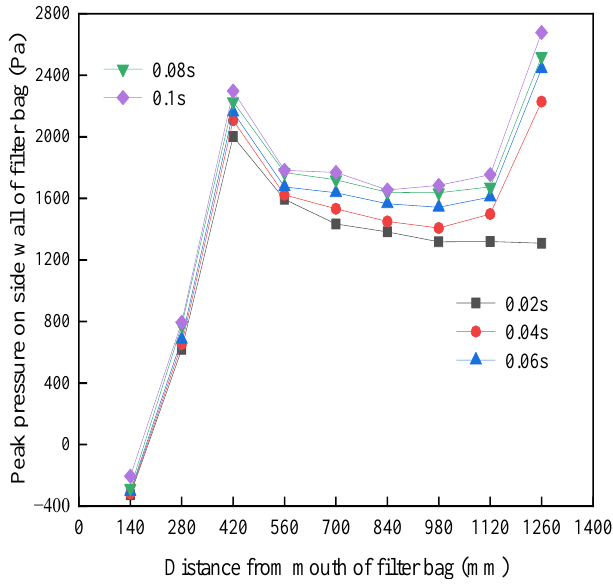
Figure 6. The peak value of the side wall pressure of the filter bag under different pulse widths.